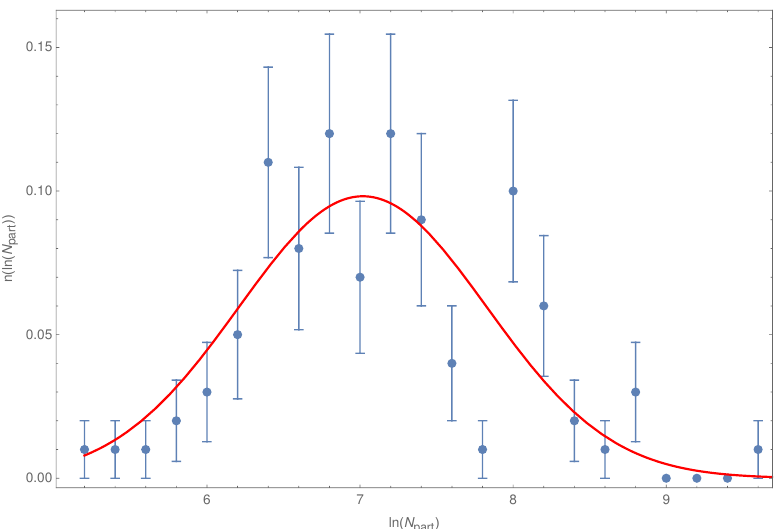
Figure 10. Probability distribution of the logarithm of the number of electrons in cascades initiated by protons with energy E = 1000 TeV. The line is the fitted Gaussian